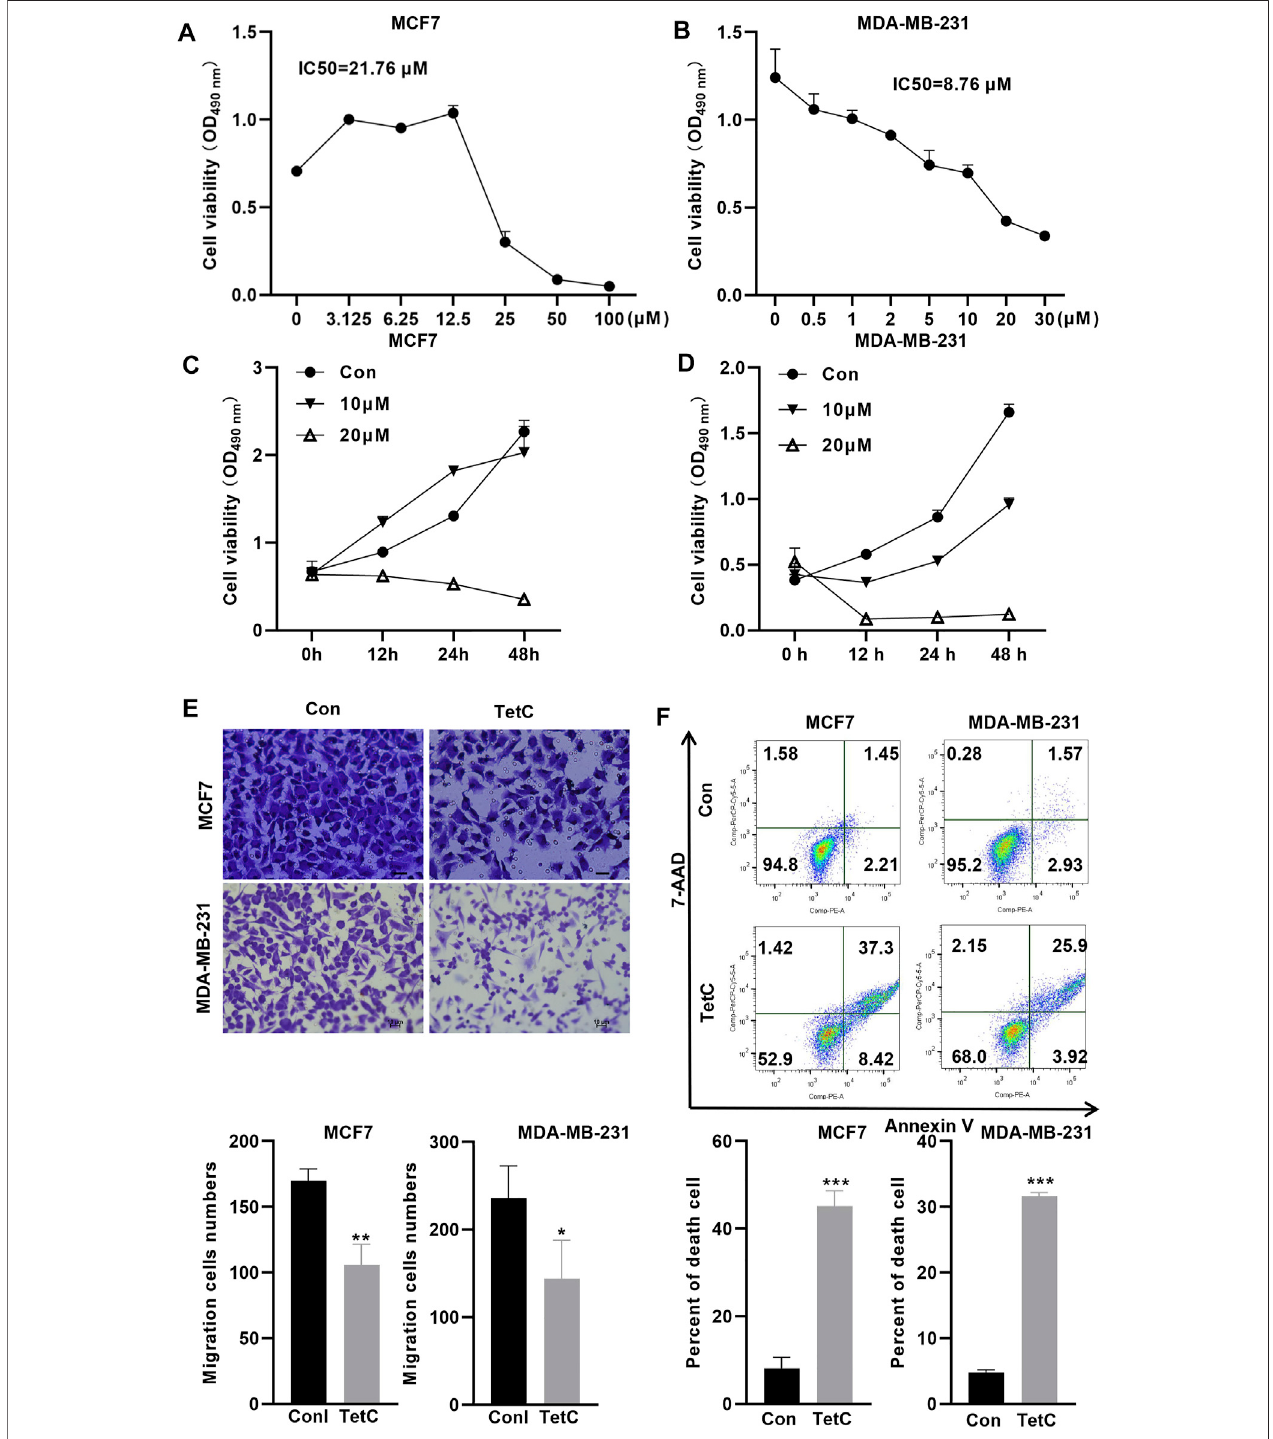
FIGURE2| TetCexertsdose-andtime-dependentproliferationinhibitoryeffectsonBCcells. (A,B) IC50ofTetCinMCF7andMDA-MB-231cellswasdetermined using MTTassay. (C,D) MCF7 andMDA-MB-231 cellsweretreatedwith20and10 μ MofTetC for0,12,24,and48 h.MTTassayshowed thatTetC exerteddose-and time-dependent proliferation inhibitory effects on MCF7 and MDA-MB-231 cells. (E) Transwell assay showed that TetC signi fi cantly suppressed BC cell migration. (F) Flow cytometry assay indicated that TetC induced MCF7 and MDA-MB-231 cell death ( n = 3 independent repeats). * p < 0.05; ** p < 0.01; *** p < 0.001.